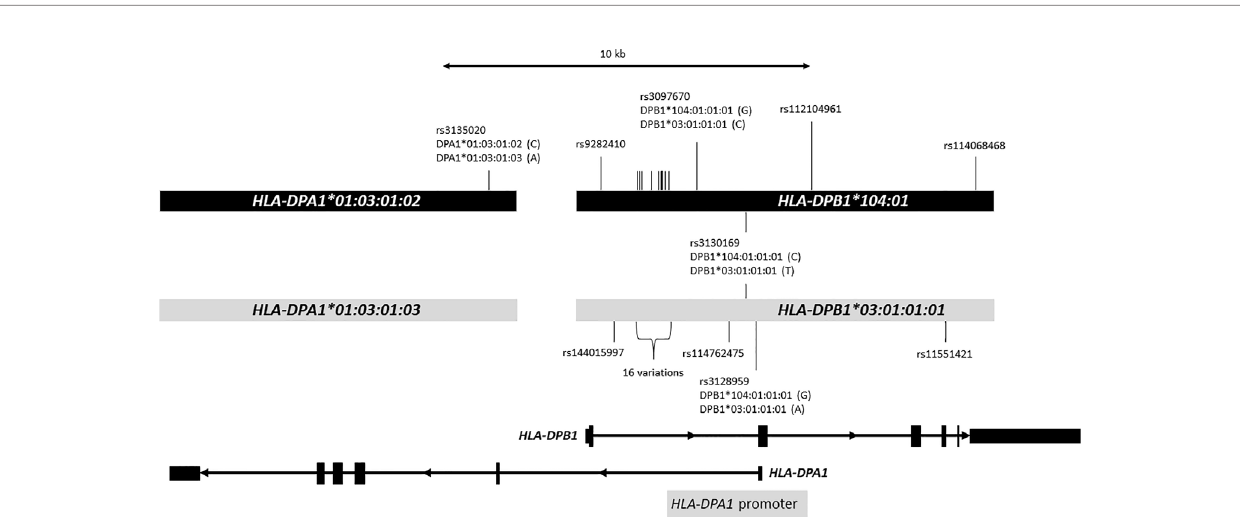
FIGURE 1 | Distinct two DP haplotypes. Figure shows a 25-kb genomic region containing HLA-DPA1 and HLA-DPB1 . HLA-DPA1 and HLA-DPB1 are shown at the bottom. Exons are depicted with rectangles, and introns are shown with thin lines with arrow that indicates the direction of transcription. The light gray bars in the middle represent DNA sequences containing HLA-DPA1*01:03:01:03 and HLA-DPB1*03:01:01:01 alleles, and the black bars represent DNA sequences containing HLA-DPA1*01:03:01:02 and HLA-DPB1*104:01:01:01 alleles. The DNA sequences of HLA-DPA1*01:03:01:02 and HLA-DPB1*104:01:01:01 alleles obtained from IPD-IMGT/HLA Database release 3.35.0 were aligned to the HLA-DPA1*01:03:01:03 and HLA-DPB1*03:01:01:01 allele sequences using the BLAT DNA sequence alignment tool. We identi fi ed 26 nucleotide variations (SNPs) indicated with vertical bars between these haplotypes; only 10 SNPs are shown with rs numbers, SNP IDs were omitted for the remaining 16 SNPs (indicated as 16 variations: rs2213307, rs2213308, rs2213309, rs2856816, rs28449420, rs7750458, rs115244420, rs116358647, rs115735976, rs2073520, rs2073521, rs2073522, rs2073523, rs7754299, rs114364259, rs114227078). Of 26 SNPs, 22 are located in intron 1 of HLA-DPB1 . HLA-DPA1 promoter depicted with gray bar at the bottom is located in the complementary strand of genomic DNA sequence that overlaps with intron 1 and exon2 of HLA-DPB1 . We observed statistically signi fi cant 4 eQTL SNPs highlighted in red. Nucleotides corresponding to HLA-DPB1 alleles for these 4 SNPs were shown in parentheses. For instance, HLA-DPB1*104:01:01:01 and HLA-DPB1*03:01:01:01 have “ G ” and “ A ” , respectively, for